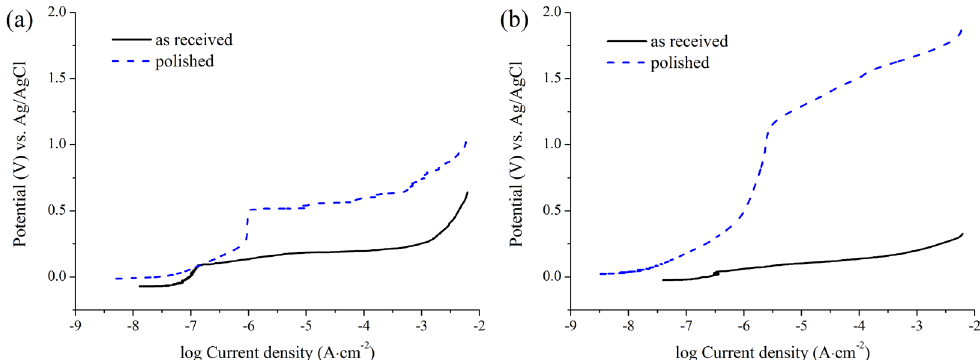
Figure 7. Potentiodynamic polarization of NiTi wires in Hank's solution: (a) superelastic and (b) shape